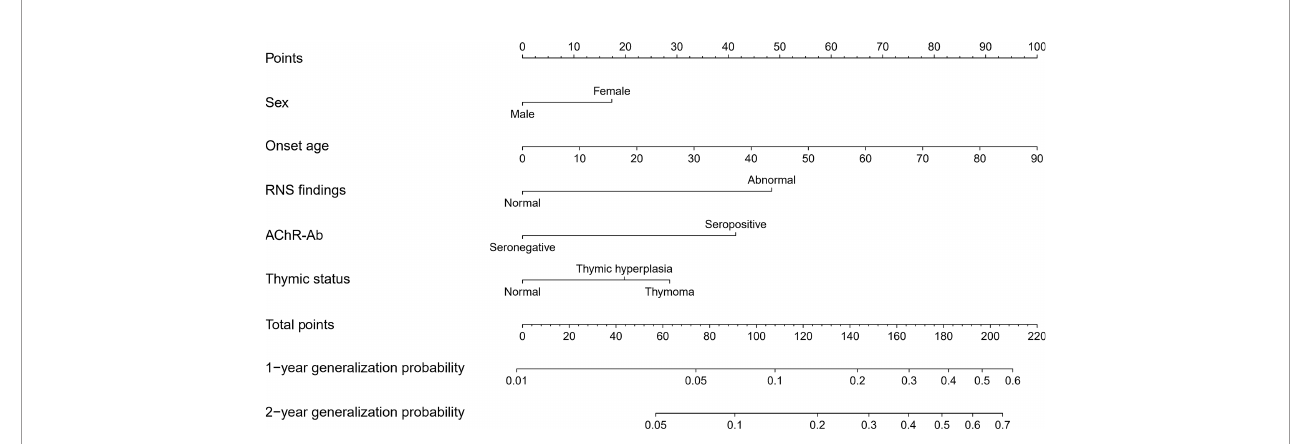
FIGURE 2 | Nomogram predicting the 1- and 2-year generalization probabilities of patients with OMG. The nomogram summed the points identi fi ed on the scale for each variable. The total points projected on the bottom scales indicate the 1- and 2-year generalization